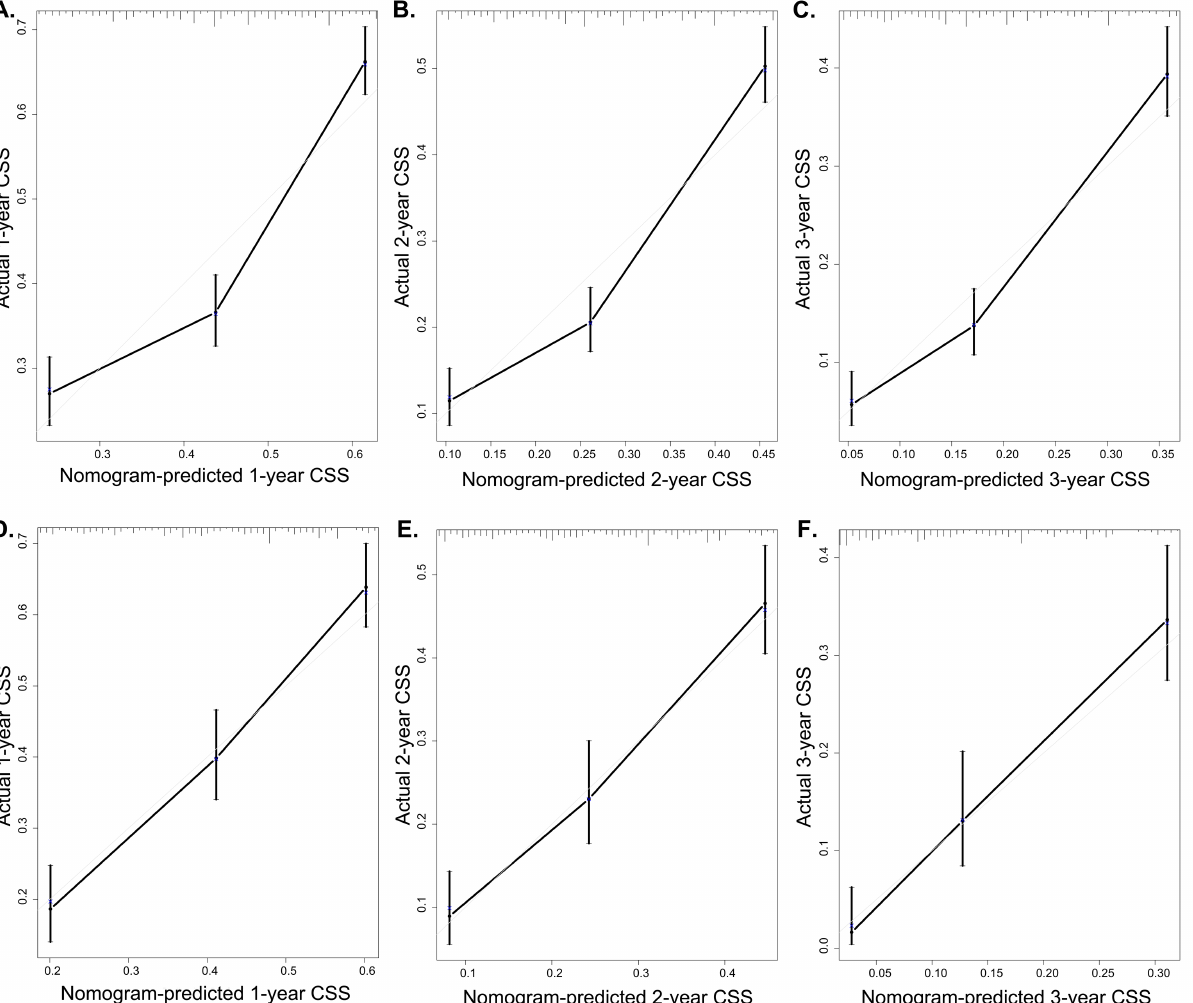
Figure 5 - Calibration plot of the 1-, 2-, and 3-year CSS nomogram. The calibration curves of the 1-year (A), 2-year (B), and 3-year (C) nomogram model for CSS in the primary cohort respectively; The calibration curves of the 1-year (D), 2-year (E), and 3-year (F) nomogram model for CSS in the validation cohort